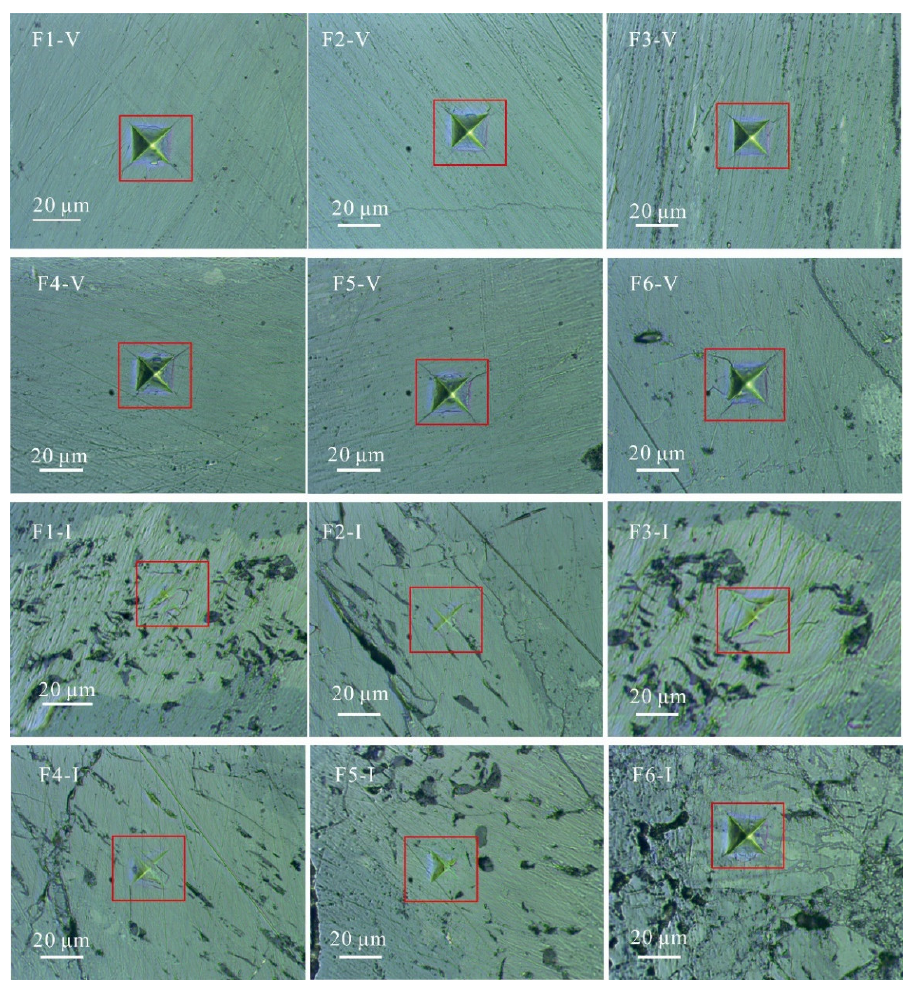
Figure 4. Typical nanoindentation image of each sample (the indentation is in the red box).